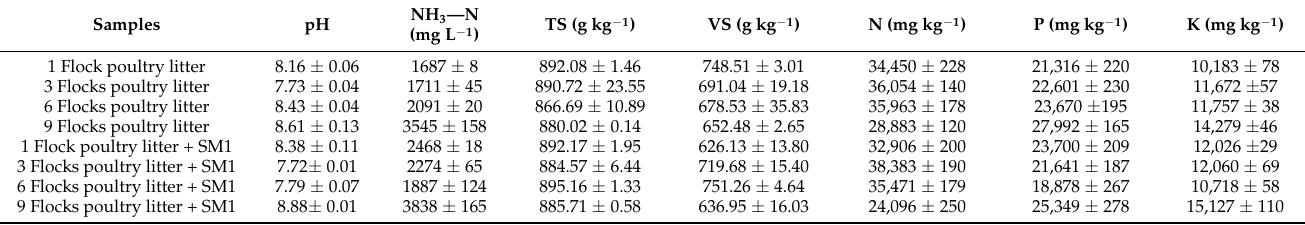
Table 1. Physico-chemical characterization of poultry litter before and 35 days after phage SM1 application.